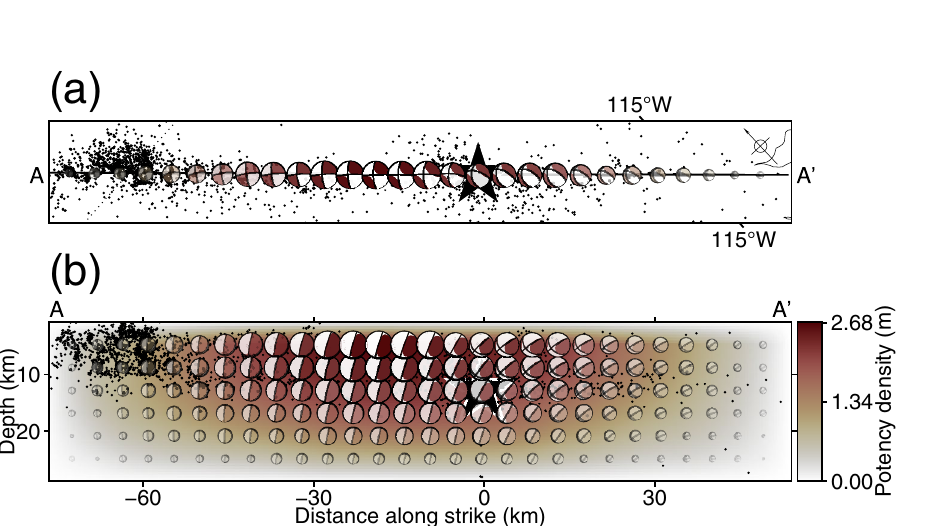
Figure 2. Summary of the inversion results. ( a ) Station distribution (triangles). Dashed circles show epicentral distances of 30° and 90°. Blue triangles indicate the stations used for the waveform fitting shown in ( b ). ( b ) Waveform fitting at the selected stations. The black and blue traces show the observed and synthesized waveforms, respectively, at each station (labelled with the station code). The sampling interval for plotting the waveforms is 0.05 s. ( c ) Moment-rate function. ( d ) Potency-rate density evolution (contour interval 0.04 m/s) projected along A–A ′ ; distance is relative to the epicentre (Fig. 1a). The vertical blue-shaded bar shows the Puerta accommodation zone 12 . This figure was made with Generic Mapping Tools (v6.2.0) 18 .